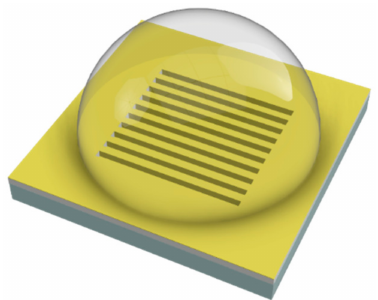
Figure 3. Outline of the functionalization process: the pre-polymeric mixture is dropped on the sensor surface and covers both the nanograting and the nearby